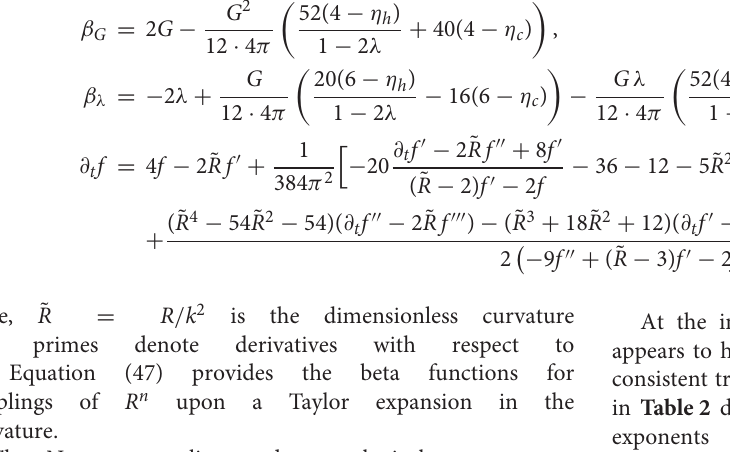
the fixed point. In Falls et al. (2013) and Falls et al. (2016), the normalized difference of canonical and quantum scaling dimension decreases with decreasing canonical dimension for R n , cf. Figure 9 . The near-Gaussian scaling spectrum (at higher orders in the curvature expansion) is also in line with the possibility to find indications of asymptotic safety from 9 A combined truncation of Gies et al. (2016) with the operators in Benedetti et al. (2009) remains to be explored. 10 Resultsintheexponentialparameterizationevenyieldonerelevantdirectionless (Ohta et al., 2016; de Brito et al.,